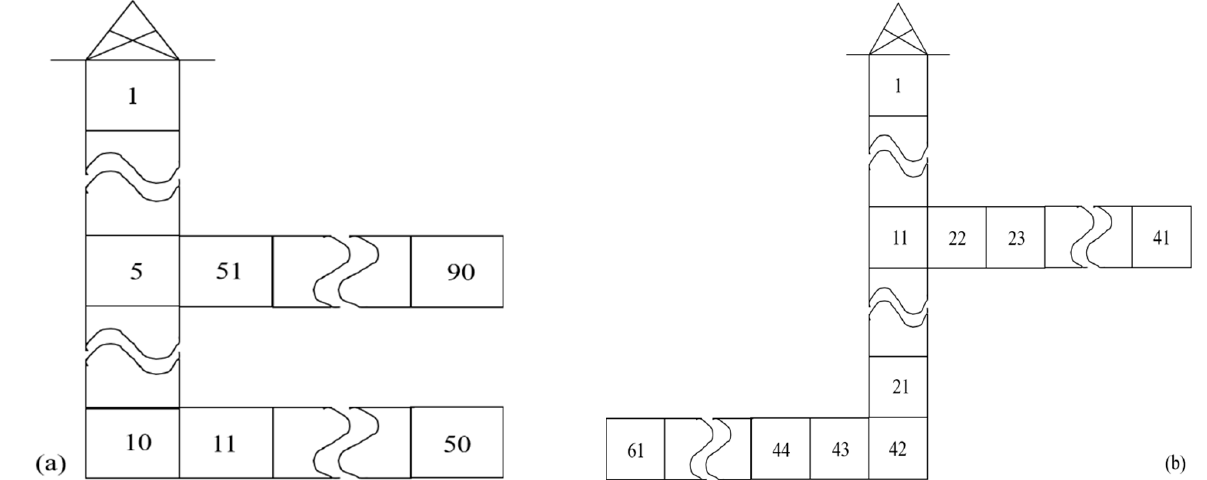
Figure 10. Schematic representation of multilateral wells: ( a ) dual-lateral well; ( b ) multilateral well with three branches. This figure was modified from Figure 2 in ref [20] and Figure 6 in ref